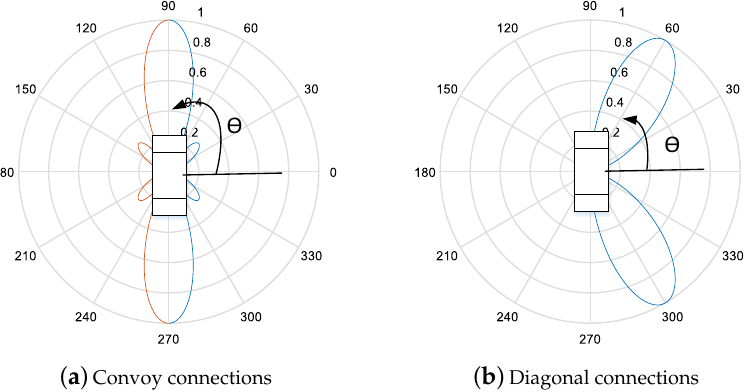
Figure 2. Beam direction and gain of linear array antenna